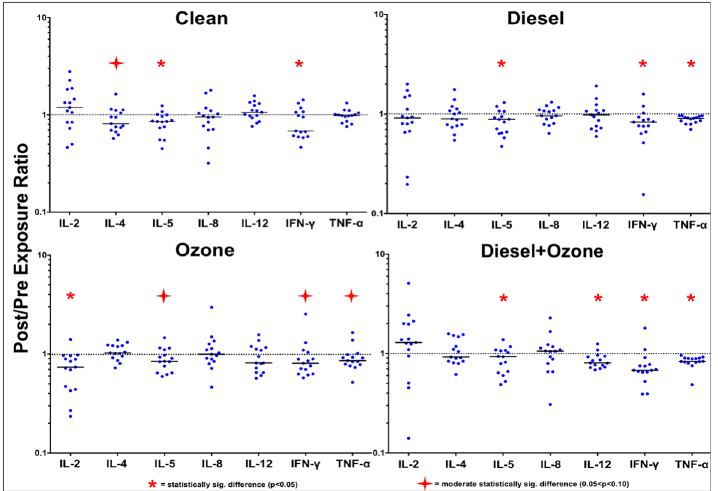
Fig 3. Post/Pre exposure cytokine concentration ratios for the four treatments. Each blue “ dot ” represents an individual Post/Pre cytokine concentration ratio for that respective treatment. A solid line in each of the cytokine scatterplots displays the median post/pre ratio. The dotted line that is anchored at “ 1 ” on each y-axis indicates the ratio where the Pre-exposure concentration is equal to the Post-exposure concentration. A statistically significant result above/below “ 1 ” indicates that there has been an increase/ decrease in the concentration for that respective cytokine at end of the 2-hour exposure period.